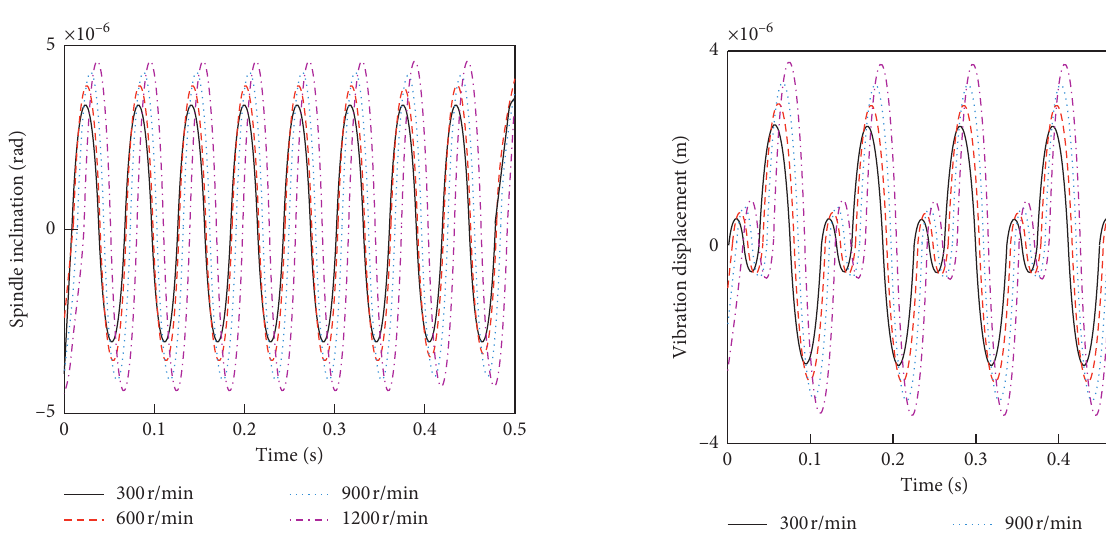
Figure 6: Variation law of spindle inclination angle at different